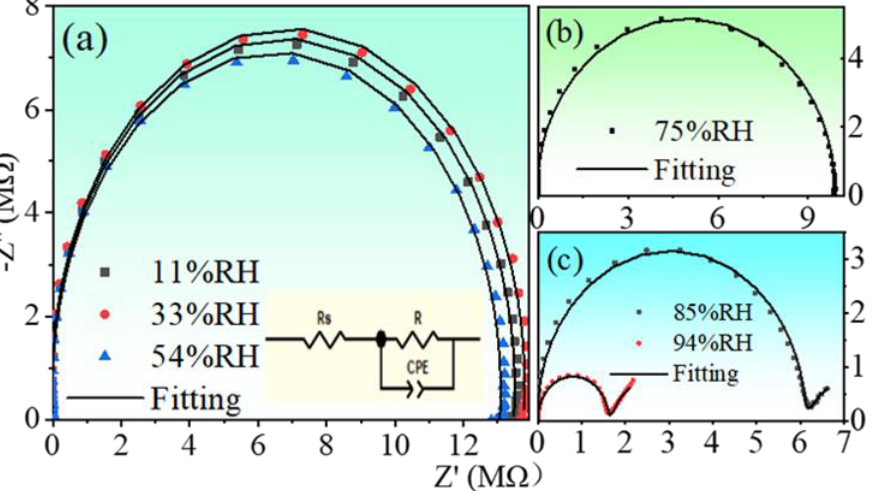
Figure 10. Complex impedance diagrams of the sensor based on nanosized HINO-0.005: ( a ) low RH levels (11, 33, and 54%); ( b ) medium RH level (75%); ( c ) high levels (85 and 94%). The inset shows the equivalent circuit used for data fittings.